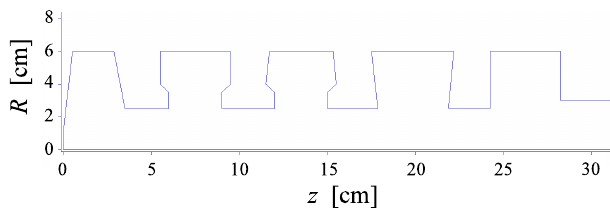
FIG. 23. Straight line approximations for elliptical (far left), reentrant (three middle), and pillbox (far right) cell geometries. Each cell radius is 6 cm, and the total length is 31.2 cm.